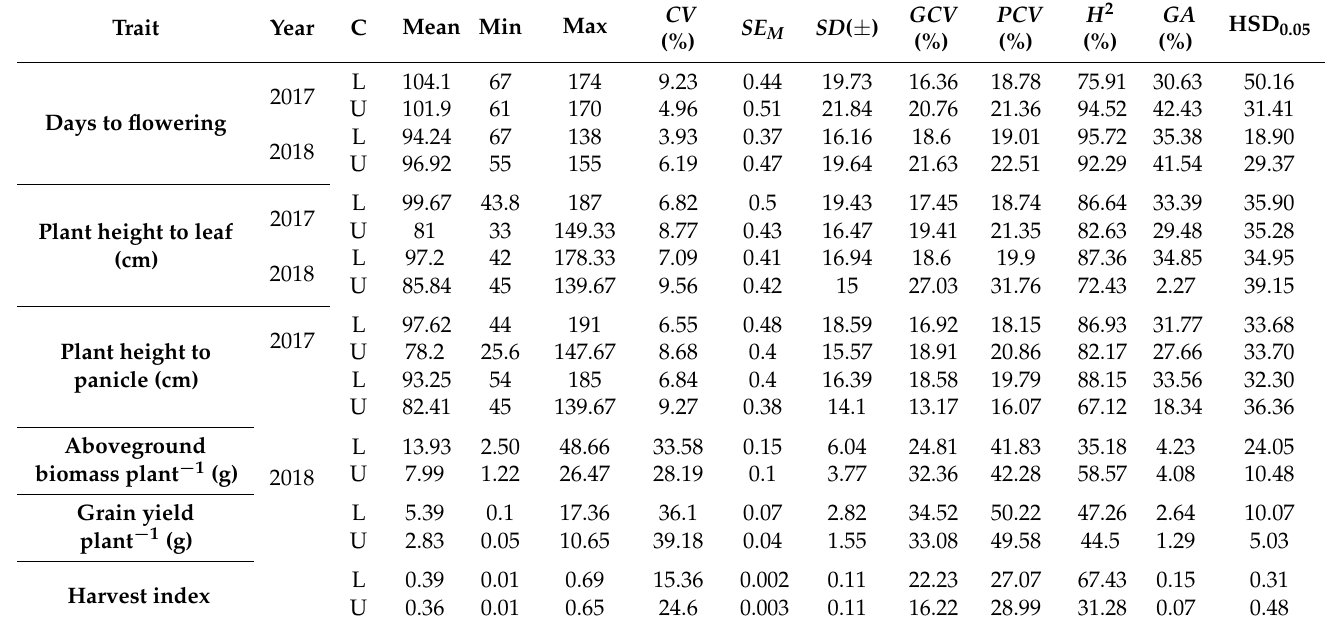
Table 5. Descriptive statistics of days to flowering, plant height to leaf, plant height to panicle, above-ground biomass plant − 1 , grain yield plant − 1 and harvest index under lowland and upland conditions in 2017 and 2018. Trait